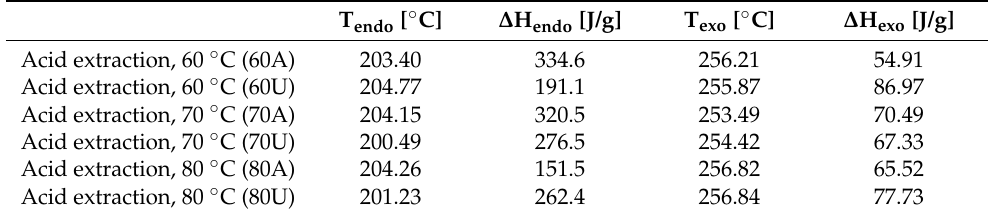
Table 5. Thermal properties of pectins determined by DSC.